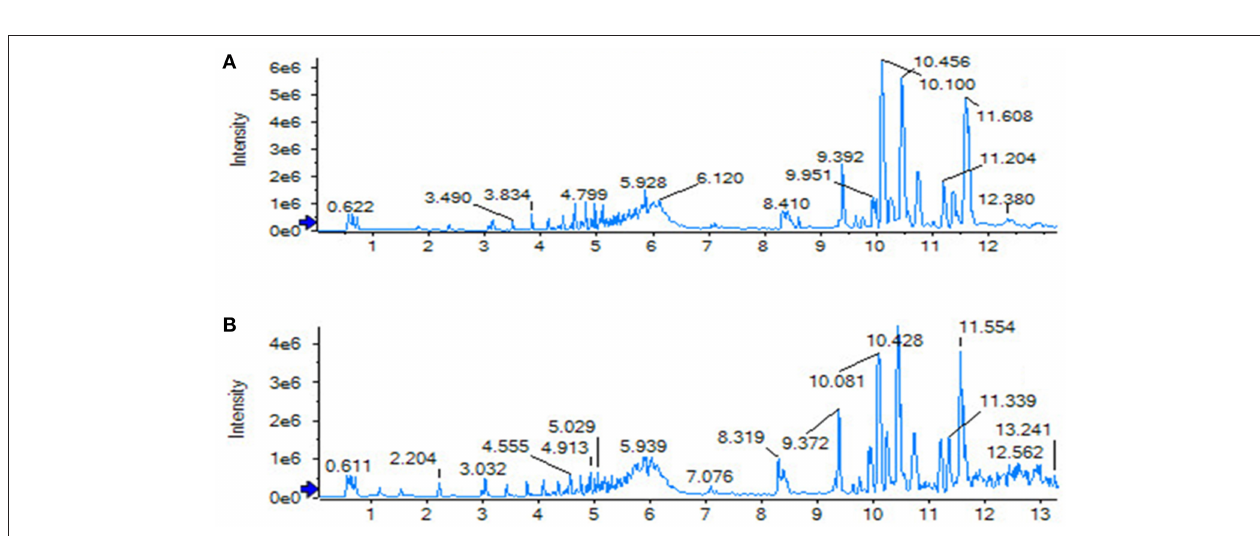
FIGURE 5 | Serum TIC map in positive ion mode. (A) Sham operation group; (B) model group.